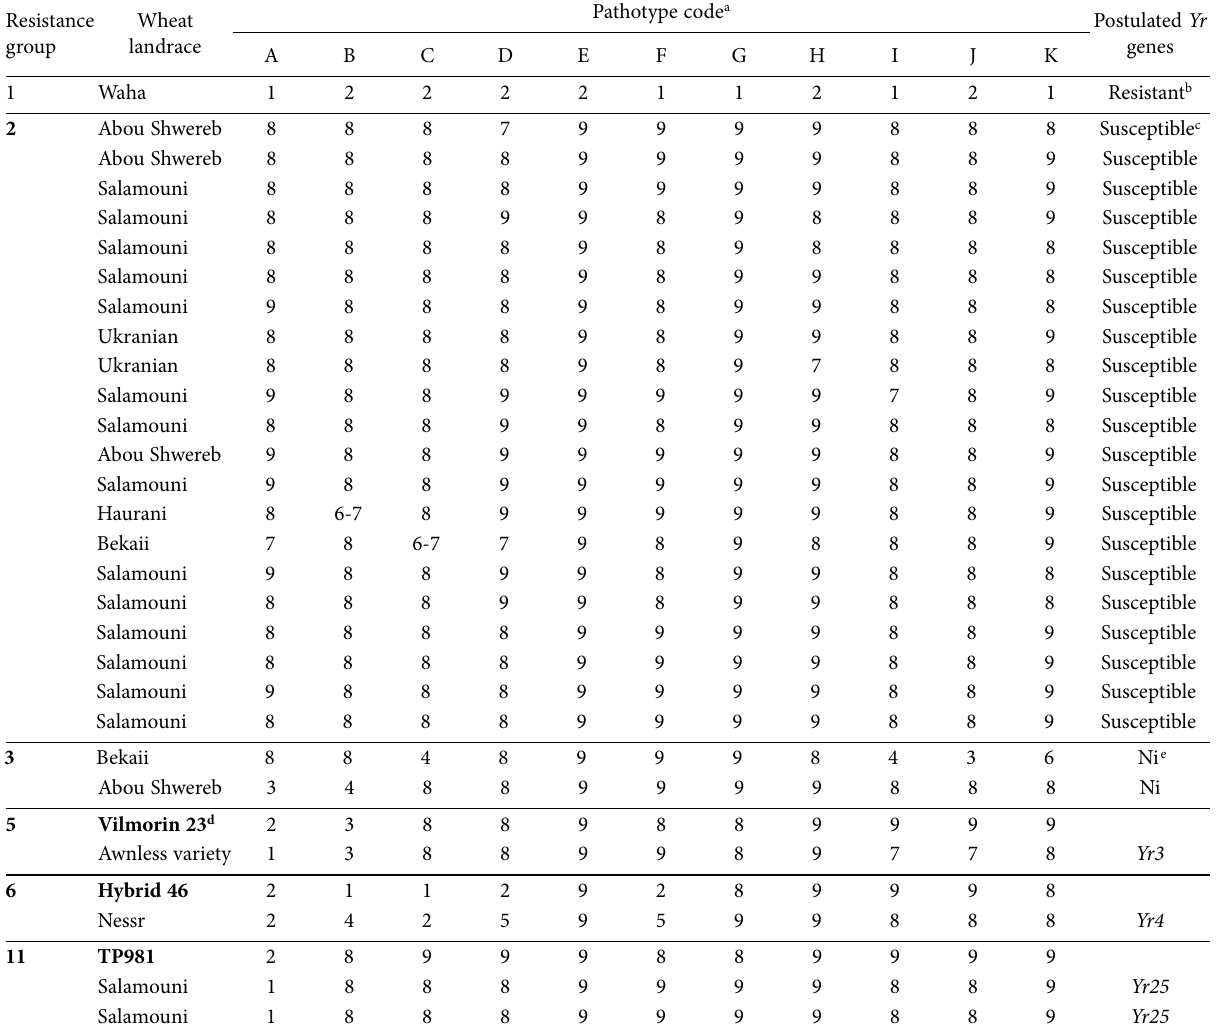
Table 4. Resistance group, infection type and postulated seedling-stage stripe rust resistance genes against 11 Puccinia striiformis f. sp. tritici pathotypes, for 28 Lebanese wheat